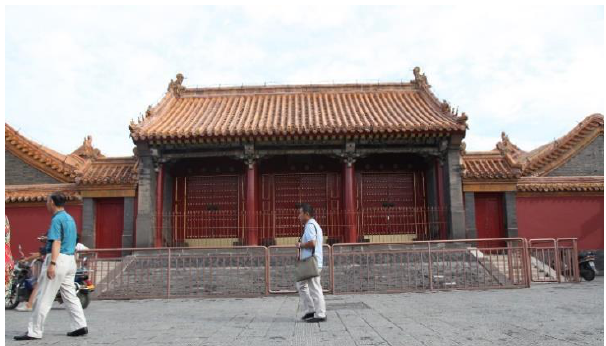
Figure 2 The main hall of Ancestral Temple in Mukden Palace